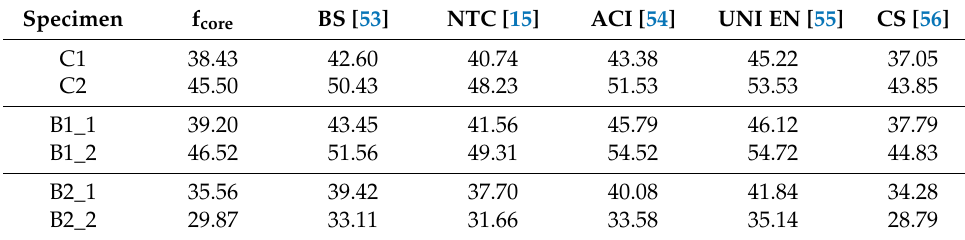
Table 3. Concrete strength according to international standard codes (MPa).